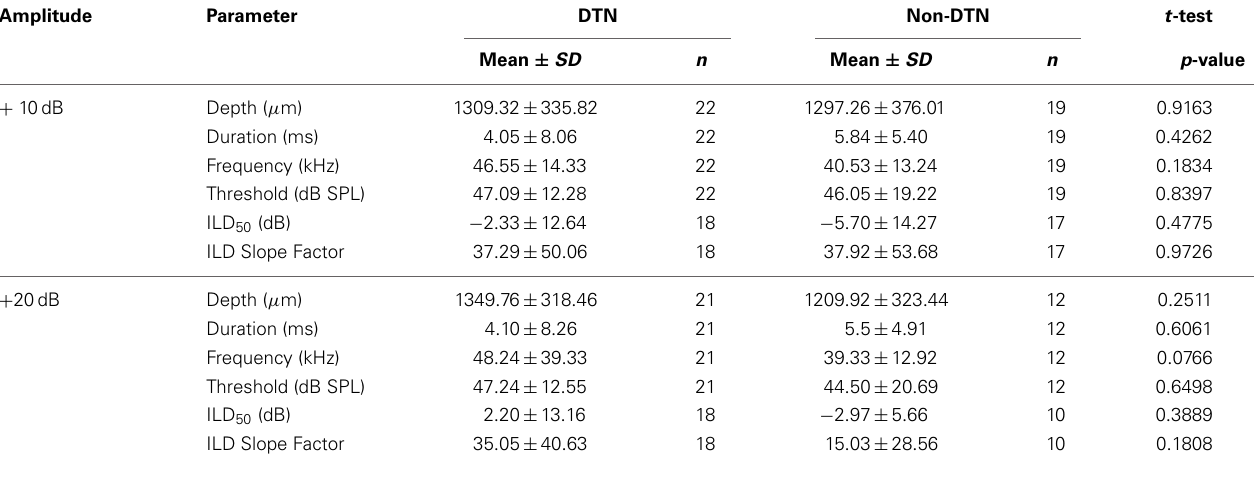
Table 4 | Comparison of electrophysiological parameters in DTNs and non-DTNs with ILD-selective response functions.